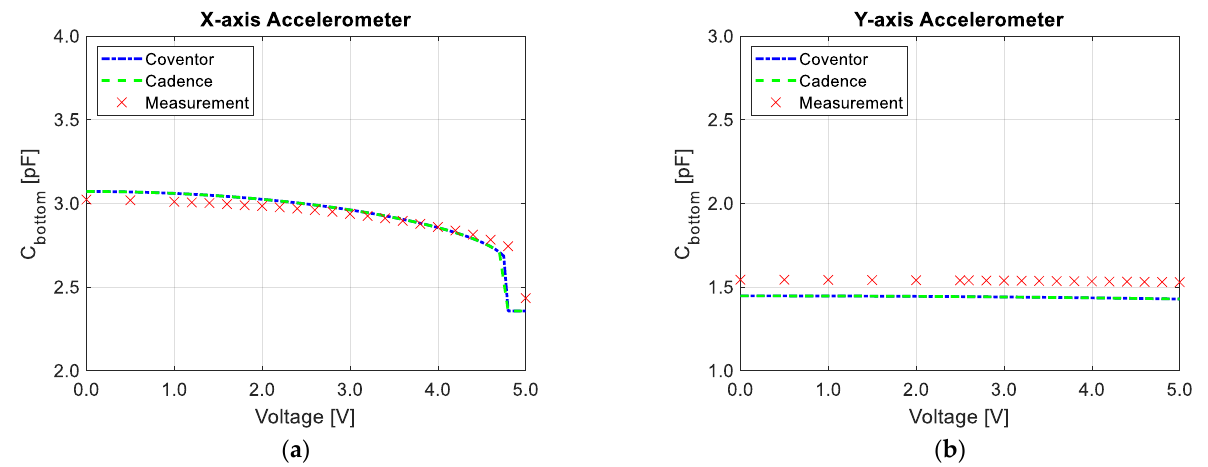
Figure 12. The value of C bottom as a function of applied voltage: ( a ) X-axis accelerometer; ( b ) Y-axis accelerometer.